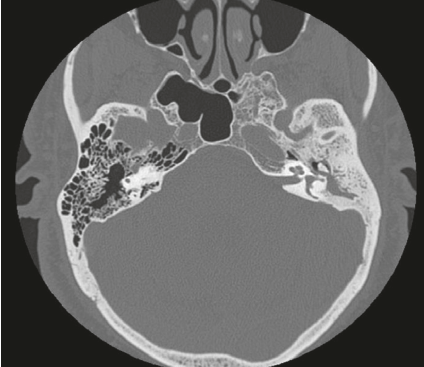
Figure 3: MRI of cerebellopontine angles and posterior fossa (coronal cut). Opacification of the left mastoid air cells and middle ear cavity with soft tissue signal which elicits low signal in T1WI and high signal in T2WI with restricted diffusion in DWI. There is homogeneous enhancement following IV contrast ad- ministration. No evidence of adjacent intracranial abscess for- mation or sinus thrombosis. The region of brain stem and cerebellar hemispheres are normal. No focal lesions are seen. Both the VII and VIII cranial nerves show normal course and signal intensity. No intra- or extra-canalicular enhancing lesion is